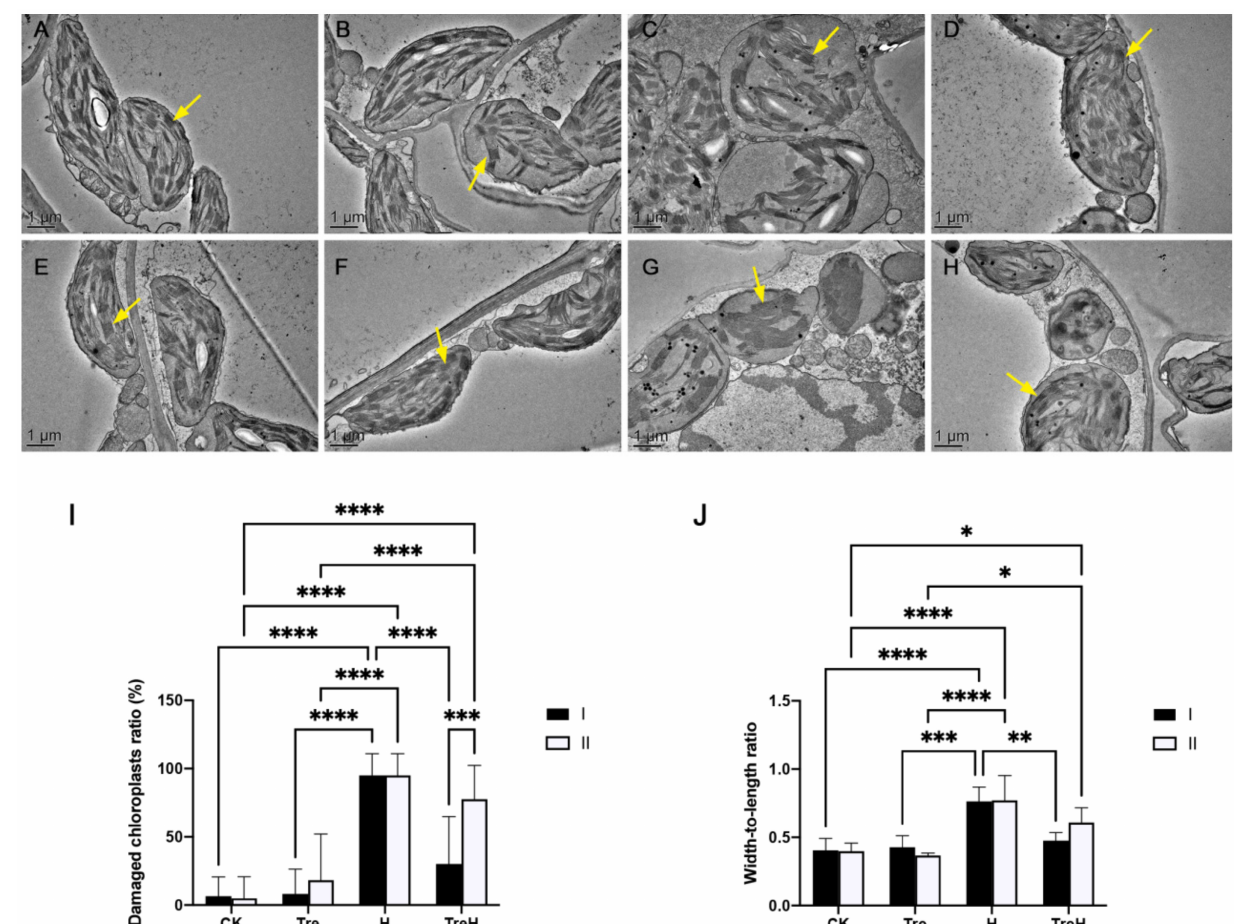
Figure 3. Chloroplast ultrastructure of two varieties of wheat ( × 2500). ( A ) Yangmai 18 without trehalose at room temperature. ( B ) Yangmai 18 trehalose pretreatment group. ( C ) Yangmai 18 without trehalose at high temperature. ( D ) Yangmai 18 high temperature trehalose pretreatment group. ( E ) Yannong 19 without trehalose at room temperature. ( F ) Yannong 19 trehalose pretreatment group. ( G ) Yannong 19 without trehalose at high temperature. ( H ) Yannong 19 high-temperature trehalose pretreatment group. Yellow arrow—thylakoid. The images were taken by a transmission electron microscope. Scale bars = 1 µ m. ( I ) Damaged chloroplasts ratio. ( J ) Width-to-length ratio of chloroplasts. I—Yangmai 18; II—Yannong 19; CK—control group; H—heat stress treatment for 24 h; Tre—trehalose pretreatment for 3 d; TreH—trehalose pretreatment for 3 d followed by high- temperature treatment for 24 h. Values are the means ± SDs ( n = 3). * indicates a significant difference at 0.01 < p ≤ 0.05, ** indicates a significant difference at p ≤ 0.01, *** indicates a significant difference at p ≤ 0.001, **** indicates a significant difference at p ≤